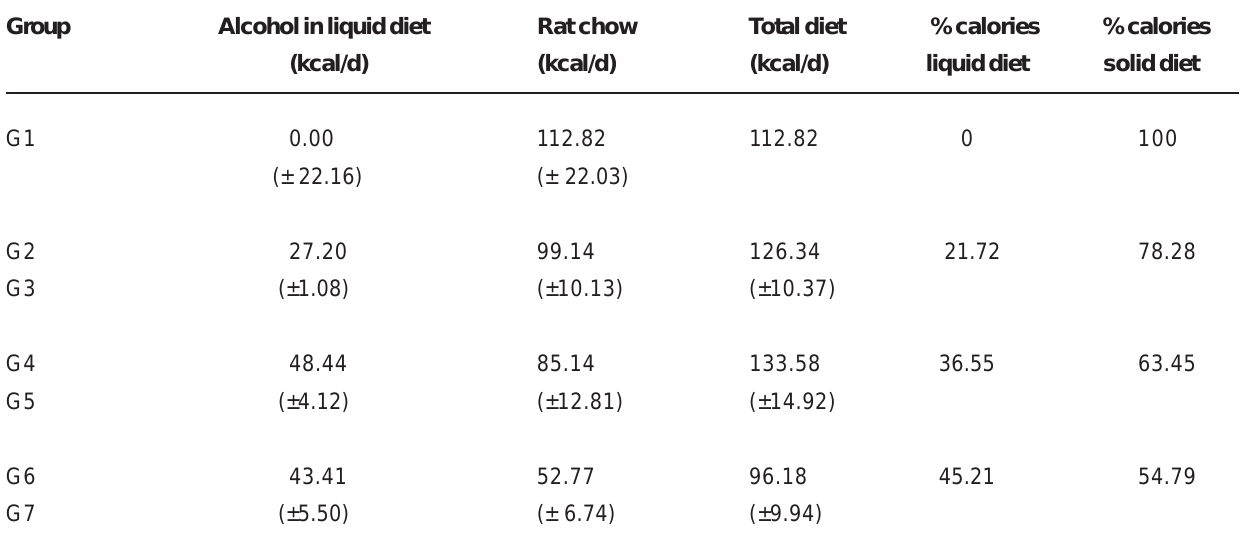
TABLE 1- Mean and standard deviation of dietary calories and caloric percentage of liquid and solid diet